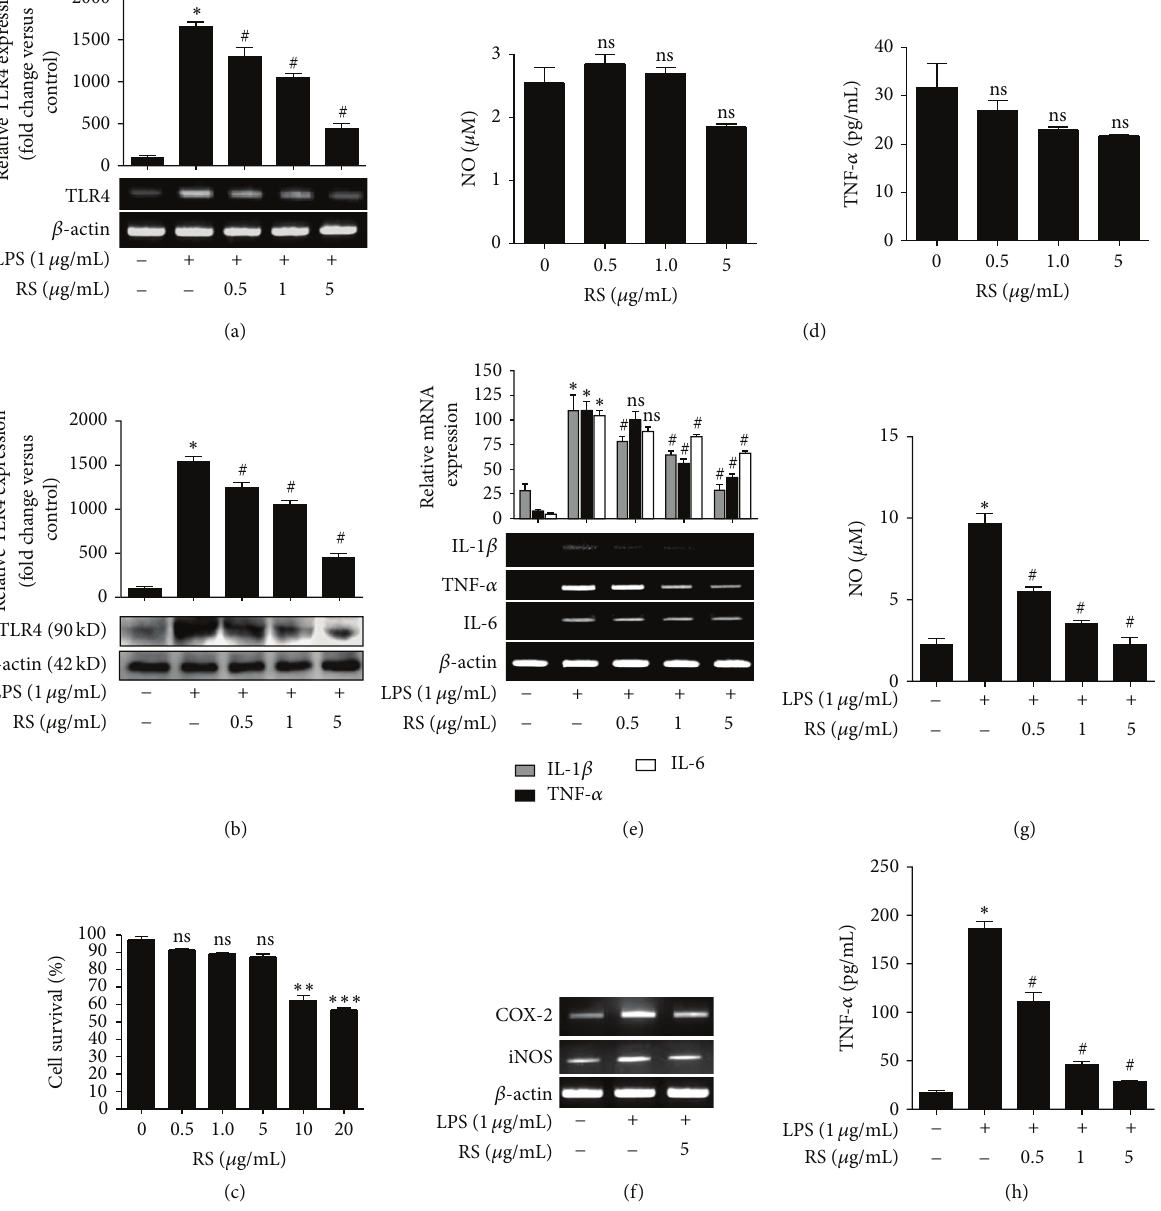
Figure 1: LPS-Rs inhibits microglia activation and inflammatory response. Microglial cells were pretreated with indicated concentration of LPS-Rs for 2hrs before treatment of LPS for indicated time. Expression of TLR4 was assayed by semiquantitative RT-PCR (6hrs) (a) and Western blot (b) (24hrs). The cell viability was measured by MTT assay (c) and NO and TNF- 𝛼 production was measured by Griess reagent and ELISA, respectively (d). The mRNA expressions of IL-1 𝛽 , TNF- 𝛼 , IL-6 (e), iNOS, and COX-2 (f) were examined by semiquantitative RT-PCR (6hrs). Nitrite released into the culture medium was assayed using Griess reagent (g) and TNF- 𝛼 in the culture supernatant was measured using ELISA (h). The error bars represent the mean ± SEM from three independent experiments ( ∗ 𝑝 ≤ 0.05 versus control and # 𝑝 ≤ 0.05 versus LPS). UN: untreated; LPS: lipopolysaccharide from Escherichia coli 055 : B5 (1 𝜇 g/mL); RS: lipopolysaccharide from Rhodobacter sphaeroides (0.5–5 𝜇